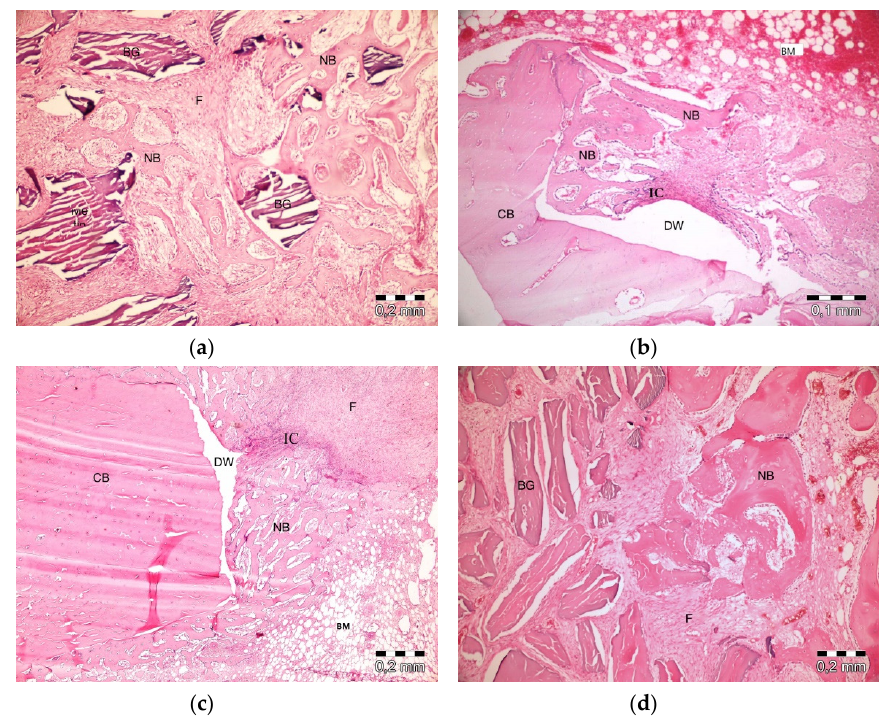
Figure 3. Histologic findings on the 10th day. ( a ): platelet-rich fibrin (PRF) + anorganic bovine bone (ABB); ( b ): PRF; ( c ): Empty Defect; ( d ): ABB + collagen membrane (CM). N: New bone area; F: Fibrosis; BG: Bone graft; DW: Defect wall; CB: Compact bone; BM: Bone marrow; IC: inflammatory cells infiltration. Materials 2019 , 12 , x FOR PEER REVIEW